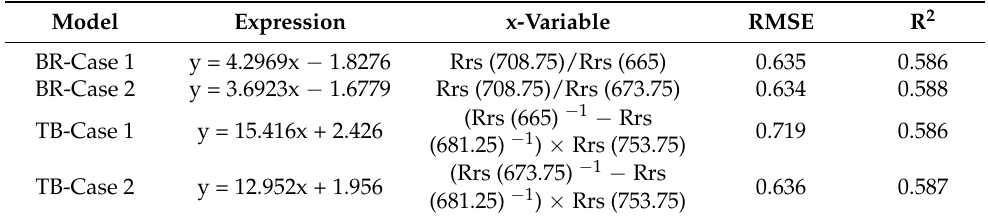
Table 6. List of the representatives of the empirical and semiempirical methods tested in this study. Model